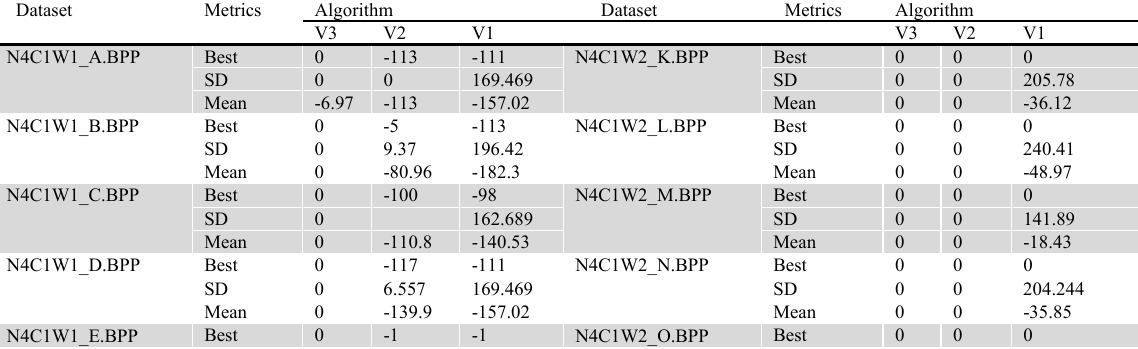
Best, mean and standard deviation values for proposed HS variations for 60 datasets with 500 objects